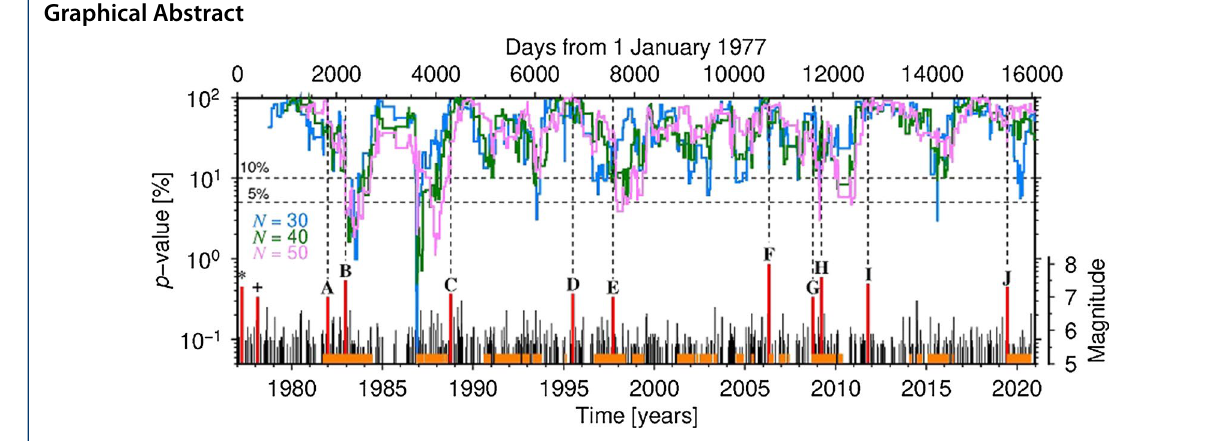
Fig. 1 Interplate (thrust) earthquakes (focal depth January 1977 to 31 December 2020 (